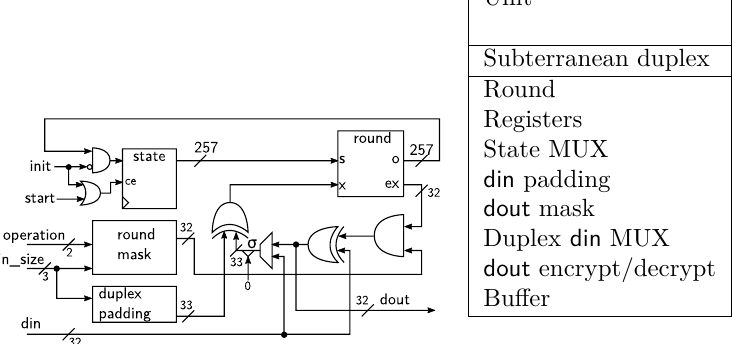
Table 3: NanGate OpenCell 45nm typical area costs for Subterranean